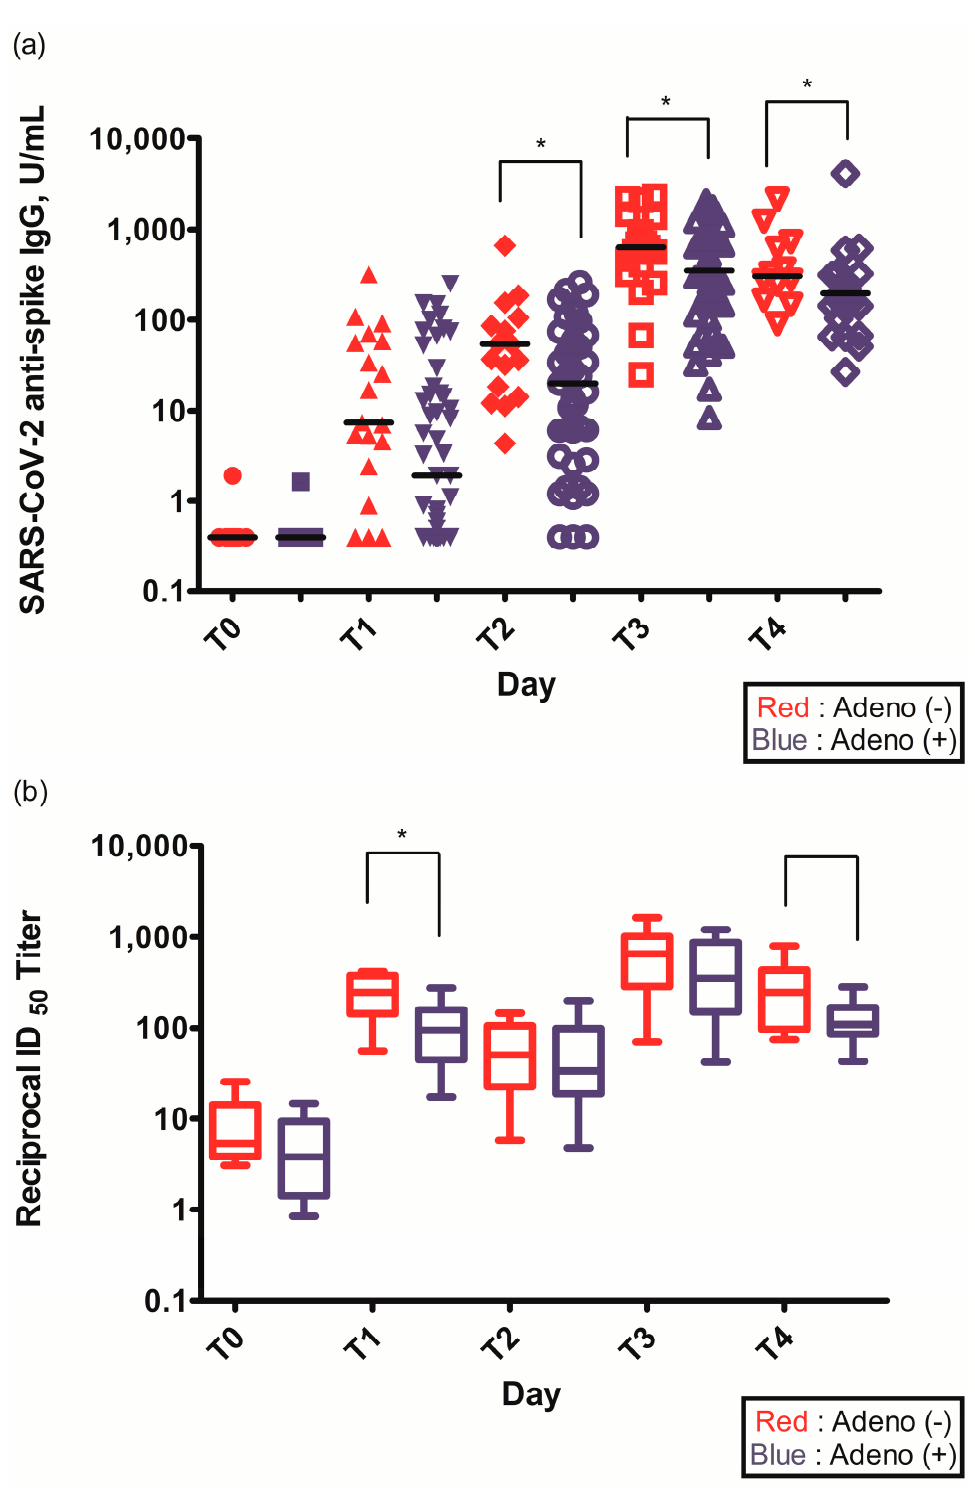
Figure 2. ( a ) Spike (S)-specific IgG titers after ChAdOx1 nCoV-19 vaccination according to pre-existing adenovirus immunity; ( b ) Plaque reduction neutralization test (PRNT 50 ) data after ChAdOx1 nCoV-19 vaccination according to pre-existing adenovirus immunity; *, p < 0.05.